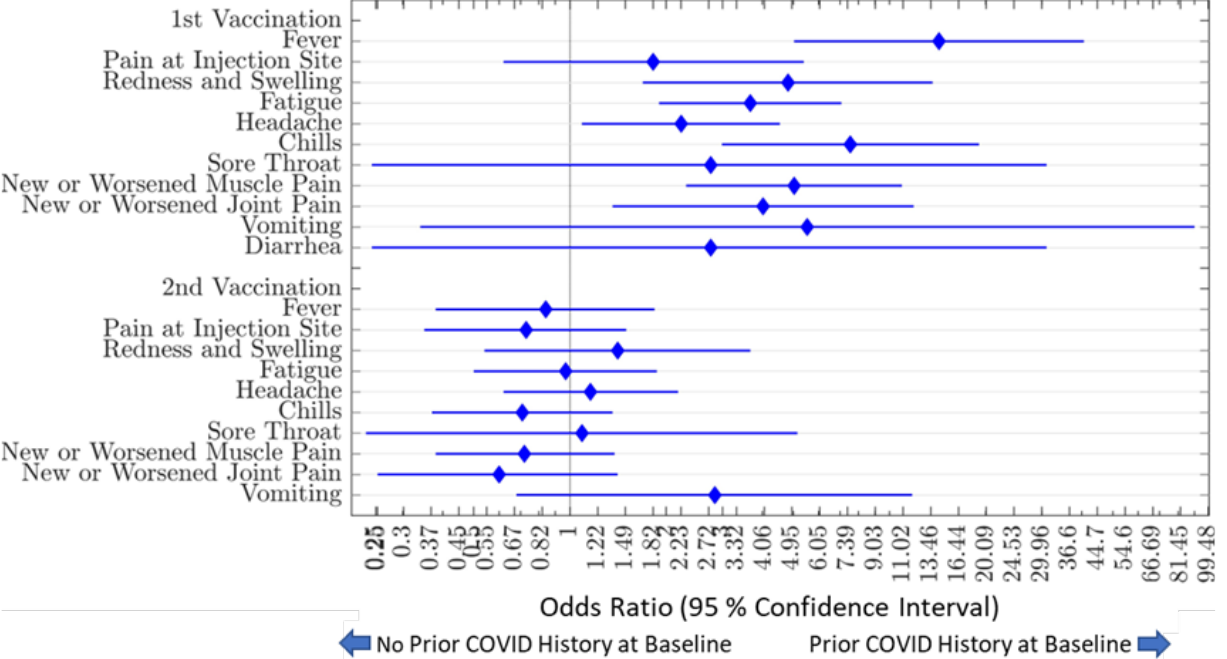
Figure 7. Odds Ratios of Vaccine-Associated Adverse Events Comparing Those With and Without Prior COVID Illness. Evaluating the associations between COVID infection history prior to vaccination and vaccine-associated adverse events, subjects who reported prior COVID infection at baseline (n = 46) were significantly more likely to have fever (OR = 14.29), redness and swelling (OR = 4.81), fatigue (OR = 3.67), headache (OR = 2.23), chills (OR = 7.54), new or worsening muscle pain (OR = 5.03), new or worsening joint pain (OR = 4.02), and taking antipyretic or anti-inflammatory medication (OR = 2.08) compared to those who reported no COVID-19 infection (n = 250) prior to vaccination. Blue diamonds represent the odds ratio of having reporting vaccine-associated adverse events. Bars to the left and right of each blue diamond represent the upper and lower confidence intervals.